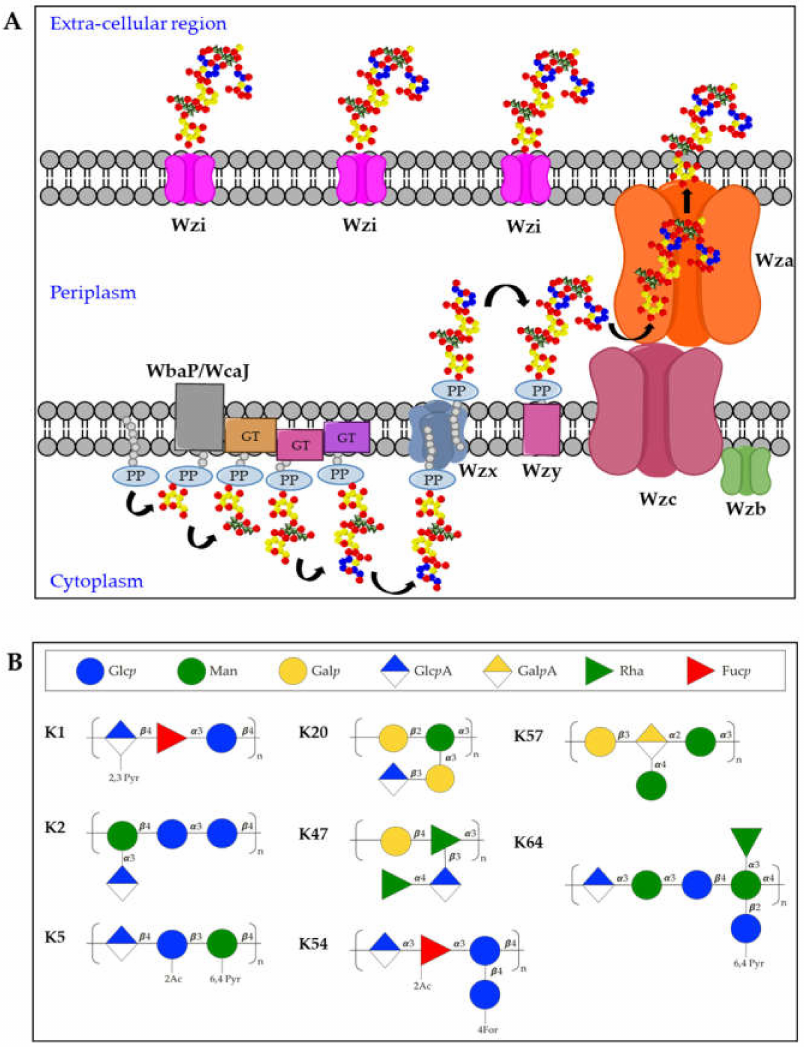
Figure 2. ( A ) Model for biosynthesis and assembly of group 1 capsules. Undecaprenol-pyrophosphate (Und-PP)-linked repeating units are assembled on the cytoplasmic leaflet of the inner membrane. Wzx then flips the newly synthesized und-PP-linked repeats across the inner membrane. In the periplasmic leaflet of the inner membrane, Wzy polymerizes the repeating units. Continued polymerization requires transphosphorylation of the Wzc oligomer and dephosphorylation by the Wzb phosphatase. Finally, the polysaccharide is translocated by Wza in the extracellular milieu where it associates with the surface protein Wzi. PP = Undecaprenyl diphosphate, GT = glycosyltransferase. ( B ) Structures of K-antigens most commonly associated to Hv-Kp